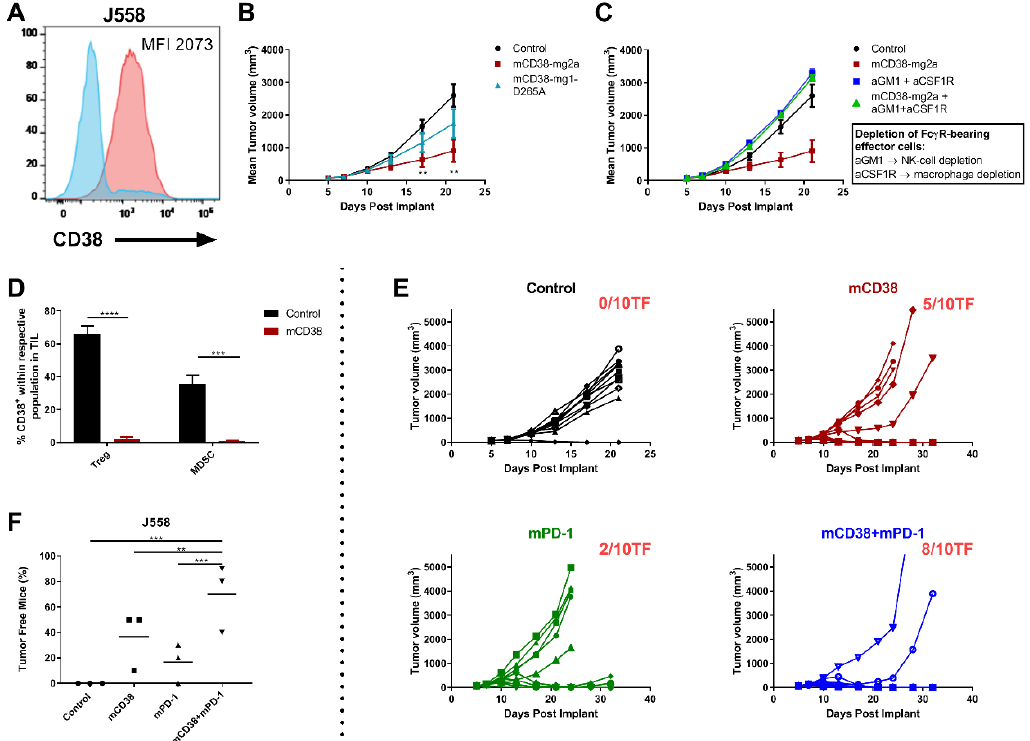
Figure 4. Enhanced antitumor activity with the combination of anti-mCD38 and anti-mPD-1 in a murine myeloma tumor model. ( A ) A representative flow cytometry histogram overlay, depicting CD38 cell surface expression on J558 MM cells (red histogram), compared with the isotype control (blue histogram). The median fluorescence intensity (MFI) is provided. ( B ) Treatment of mice with FcR-engaging or Fc γ R-inert mAbs. BALB / c mice were injected subcutaneously with J558 tumor cells (5 × 10 6 cells) and randomized at day 6 when their tumors reached an average size of 90–100 mm 3 . Mice were injected intraperitoneally with 10 mg / kg of either control mIgG2a and control mIgG1-D265A (black), anti-mCD38 mIg2a (red), or anti-mCD38 mIgG1-D265A (inert antibody, blue) on days 6, 10, and 13. Data are the mean ± SEM ( n = 10 mice / group). ( C ) Effect of depletion of Fc γ R-bearing effector cells. J558 tumor-bearing mice were injected intraperitoneally with anti-asialo-GM1 (resulting in NK-cell depletion) and anti-CSF1R (resulting in macrophage depletion) on day 5 (1 day prior to anti-mCD38 mAb treatment) and every 7 days thereafter. Data are the mean ± SEM ( n = 10 mice / group). ( D ) Tumor-infiltrating mononuclear cells from J558 tumor-bearing mice were harvested on day 11 post-implantation, following treatment with anti-mCD38 or mIgG2a control mAb. Percentage of CD38 + cells within population of Tregs (%CD4 + Foxp3 + ) or MDSCs (%Gr1 + CD11b + ) is shown. Data are depicted as the mean ± SEM and are from a representative experiment with 5 mice per group. ( E ) BALB / c mice were injected subcutaneously with J558 tumor cells (5 × 10 6 cells) and randomized at day 6 when their tumors reached an average size of 90–100 mm 3 . Mice were injected intraperitoneally with 10 mg / kg of either control mIgG2a or anti-mCD38 mAb, 0.3 mg / kg anti-mPD-1, or combination of anti-mCD38 / anti-mPD-1 mAbs on days 6, 10, and 13. Tumor volumes for individual mice and the number of tumor-free mice per group are shown; n = 10 per group. This experiment is representative for a total of 3 independent experiments. ( F ) Fisher’s Exact test (two-sided) analysis to determine between-treatment differences in the proportion of J558-bearing mice that were tumor free. Three independent tumor studies were performed with 10 mice per treatment per study. Symbols represent different studies within a treatment group. Abbreviations: mAb, monoclonal antibody; TIL, tumor-infiltrating lymphocytes; SEM, standard error of mean; ** p ≤ 0.01, *** p ≤ 0.001, **** p ≤